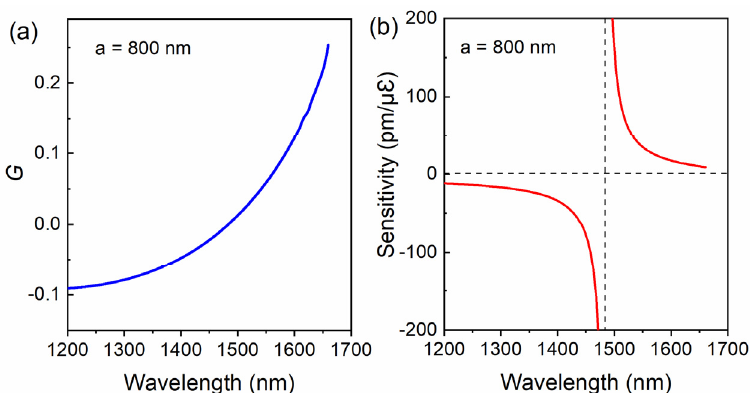
Figure 3. ( a ) Effective refractive index difference between the odd and even modes. ( b ) The strain sensitivity of the